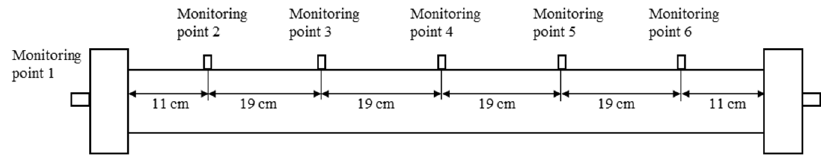
Figure 5. Distribution of the pressure monitoring points. Table 2. The basic data of the sand-packed models.